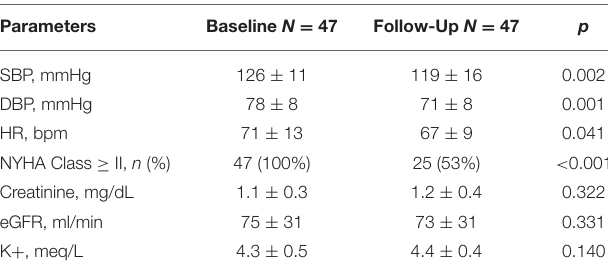
TABLE 2 | Baseline vs. follow up clinical